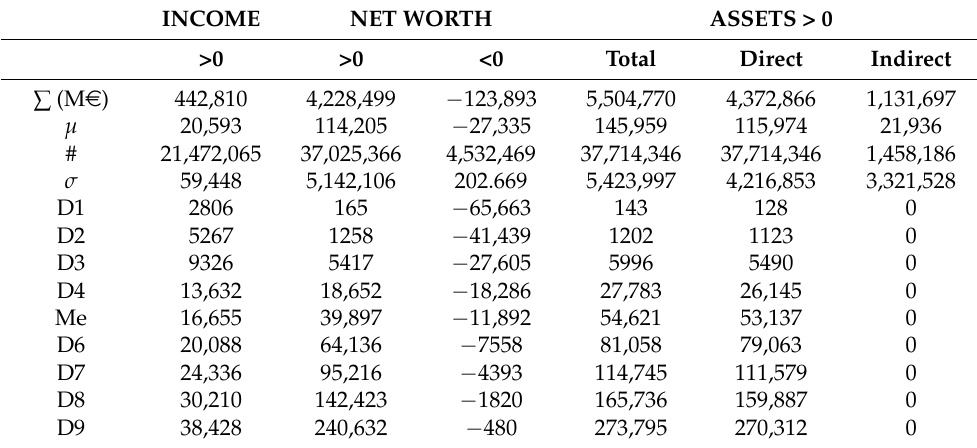
Table 1. Descriptive statistics of wealth distribution in Spain